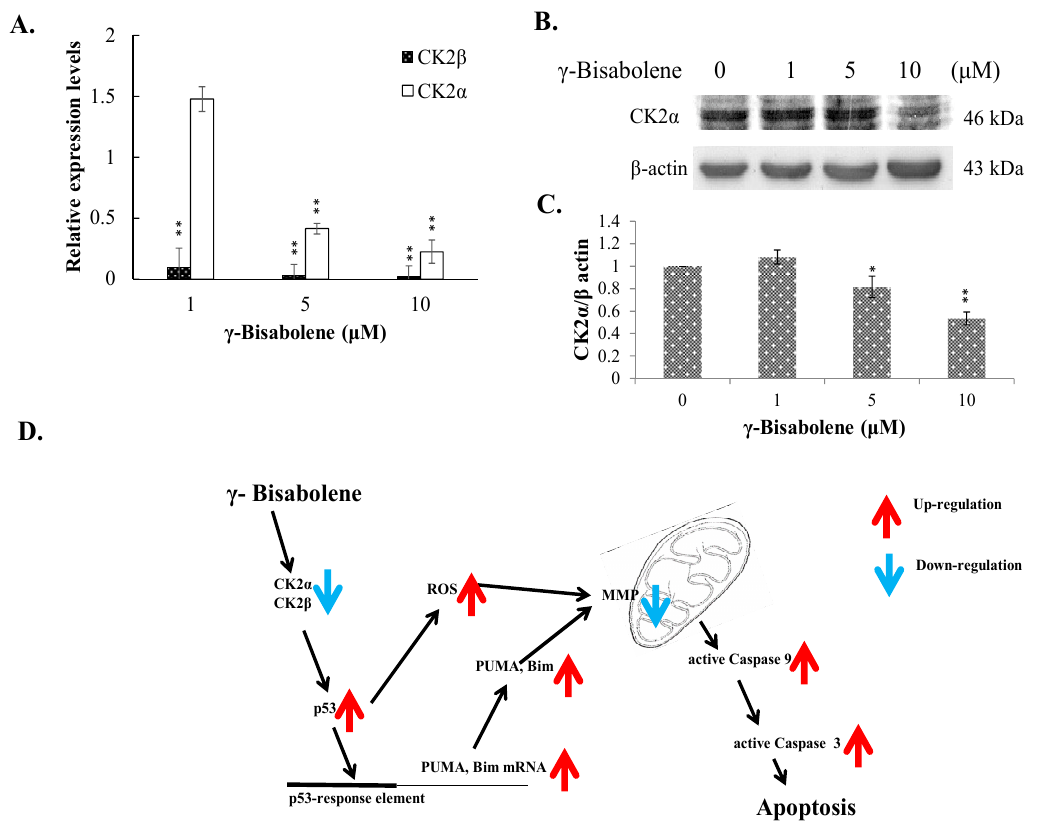
Figure 7. Decrease of CK2 α / β expression in γ -bisabolene-treated cells. Cells were treated with γ -bisabolene for 48 h, and then harvested for real time PCR ( A ) and western blot assays ( B , C ); Relative mRNA levels of CK2 α and CK-2 β were normalized by GAPDH, and then compared to un-treated cells, respectively. Relative band intensity of CK2 α was normalized by β actin, compared to the mock cells, and quantified using imageJ based on triplicate replicates of each experiment ( C ); GeneGO Meta-Core pathway analysis of the results predicts p53-mediated apoptosis pathway in treated cells ( D ). *, p value < 0.05; **, p value < 0.01 compared with untreated cells.